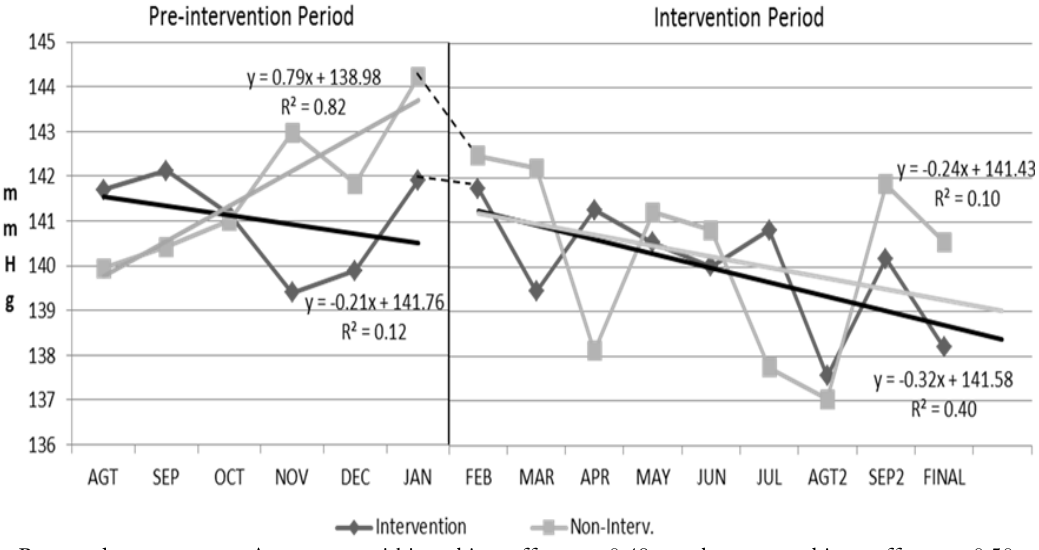
Figure 1. Monthly Systolic Blood Pressure, Trend line, and Equation of Intervention vs. Non- Intervention